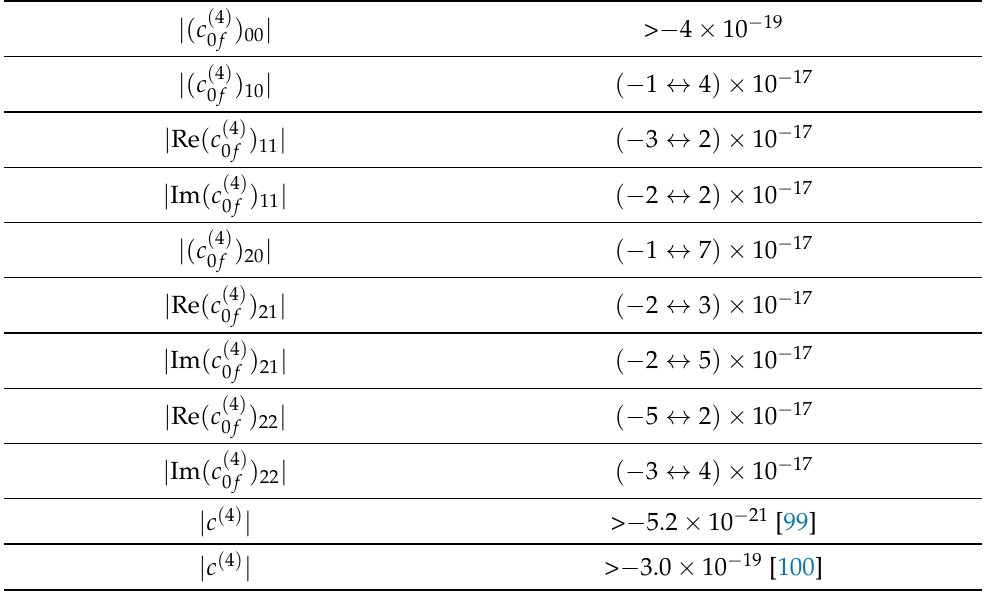
Table 3. IceCube neutrino bounds on LIV for dimension four operators from the SME. Limits extracted from Ref. [81], except where